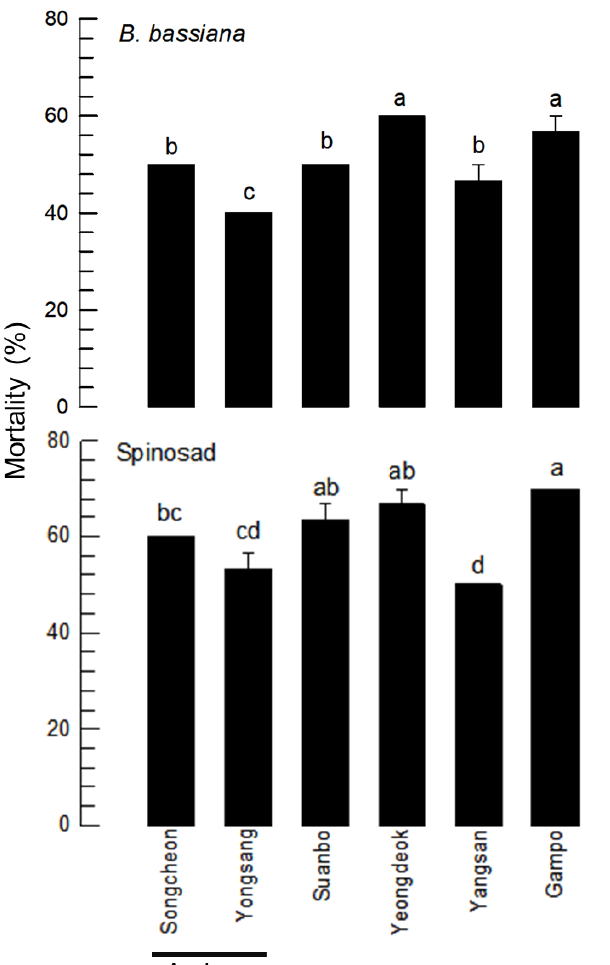
Figure 4. Variation in insecticide susceptibility of T . tabaci infesting Welsh onion. Beauveria bassiana (‘Bb’) and Spinosad at 1.17 × 10 6 conidia/mL and 50 ppm, respectively, were sprayed to assess thrips’ susceptibility to them. Insecticidal activities of Bb and Spinosad were evaluated at 5 days and 4 days after treatment, respectively. Each treatment used 10 adults and replicated three times. Different letters above means were different using among means at Type I error = 0.05 (LSD test).